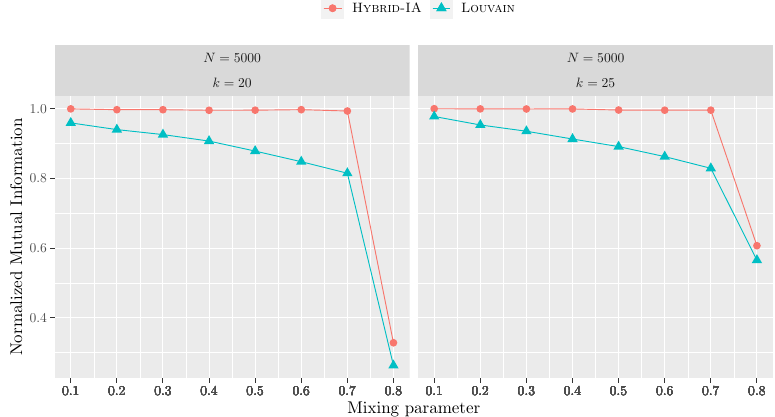
Figure 9. Performances of H YBRID -IA and L OUVAIN on the LFR instances with 5000 nodes and average degrees 20 and 25. The plots show the normalized mutual information as a function of the mixing parameter. Each point corresponds to an average over 5 produced graphs and 100 runs.